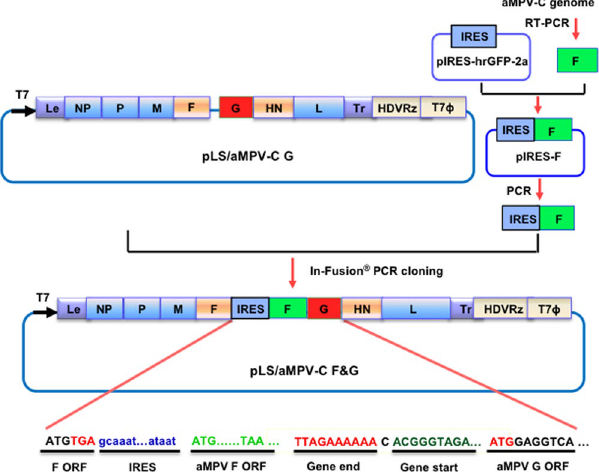
Figure 1. Schematic representation of pLS/AMPV-C F&G construction. The open reading frame of the AMPV-C F gene, amplified from viral genomic RNA, was cloned into the pIRES-hrGFP-2a vector (pIRES, Clontech, Mountain View, CA) downstream of the IRES sequence. Subsequently, the IRES and the AMPV-C F ORF sequences were amplified and cloned into the pLS/AMPV-C G vector downstream of the NDV F ORF using an In-Fusion PCR Cloning Kit (Clontech). The NDV Gene Start and Gene End signal sequences and the AMPV-C F and G ORF sequences are underlined. The direction of the T7 promoter is indicated by a bold black arrow. HDVRz and T7 Φ represent the site of the Hepatitis delta virus ribozyme and the T7 terminator sequences, respectively.